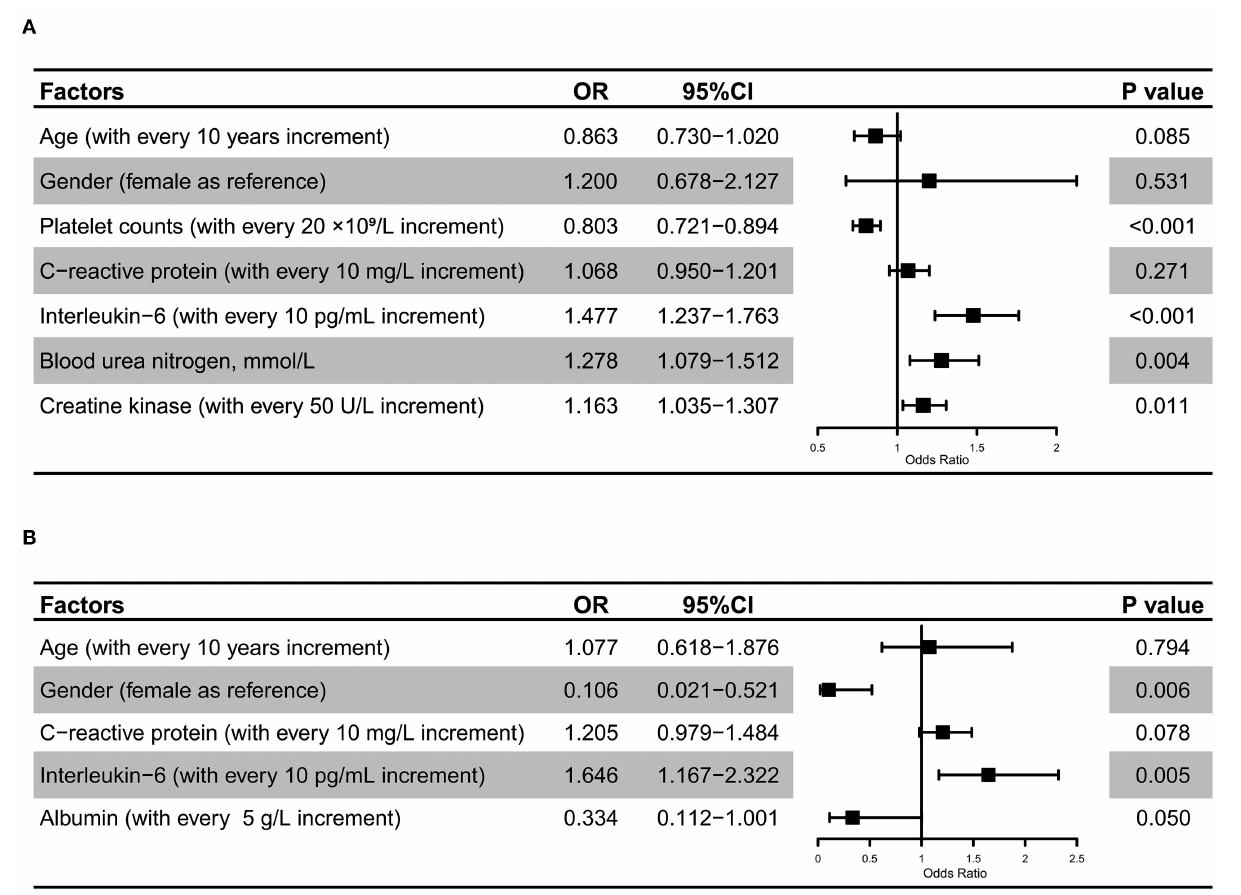
FIGURE 5 | Risk factors for SARS-CoV-2 infection-induced sepsis. Multivariate regression analysis revealed that IL-6, BUN, and CK levels, and platelet counts were significantly associated with the development of SARS-CoV-2 infection-induced sepsis (A) . Multivariate regression analysis revealed that gender and IL-6 were significantly associated with the progression to critically ill cases among septic COVID-19 patients (B)